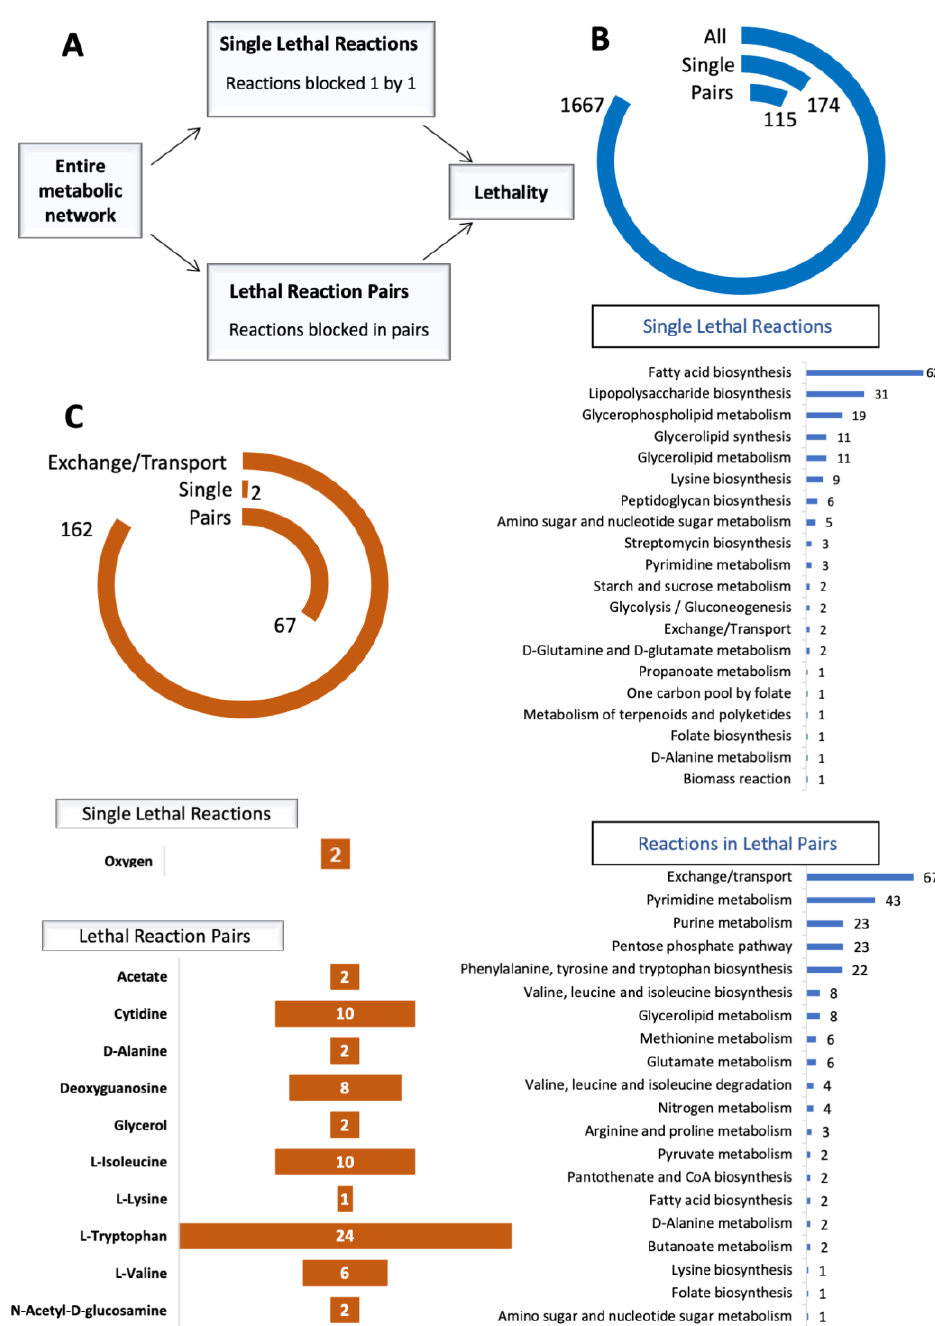
Figure 2. ( A ) Study design for synthetic lethality analysis. ( B ) Single lethal reactions, lethal reaction pairs, and related pathways. Blue circle plot shows numbers of single lethal reactions (Single), lethal reaction pairs (Pairs) and all reactions in the model (All). Chart bar of single lethal reactions shows numbers of involved reactions in each pathway. Chart bar of reactions in lethal pairs shows numbers of individual reactions in each pathway. ( C ) Single lethal exchange/transport reactions, exchange/transport reactions in lethal reaction pairs and related metabolites. Brown circle plot shows numbers of single lethal exchange/transport reactions (Single), exchange/transport reactions in lethal reaction pairs (Pairs), and all exchange/transport reactions in the model (Exchange/Transport). Bar chart of single lethal reactions shows numbers of exchange/transport reactions and related metabolites. Bar chart of lethal reaction pairs shows numbers of individual exchange/transport reactions and related